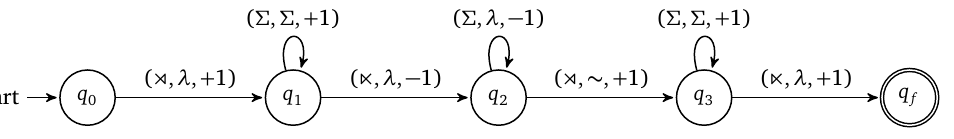
Figure 1: 2-way D-FST for total reduplication